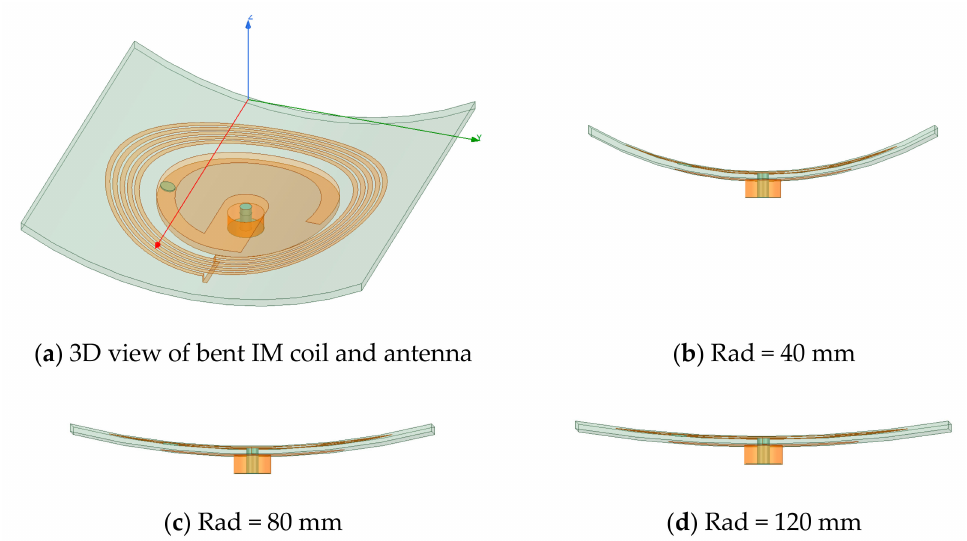
Figure 4. The IM hybrid design under three bending conditions. ( a ) three dimensional views of bent RX, ( b ) Rad = 40 mm, ( c ) Rad = 80 mm, and ( d ) Rad = 120